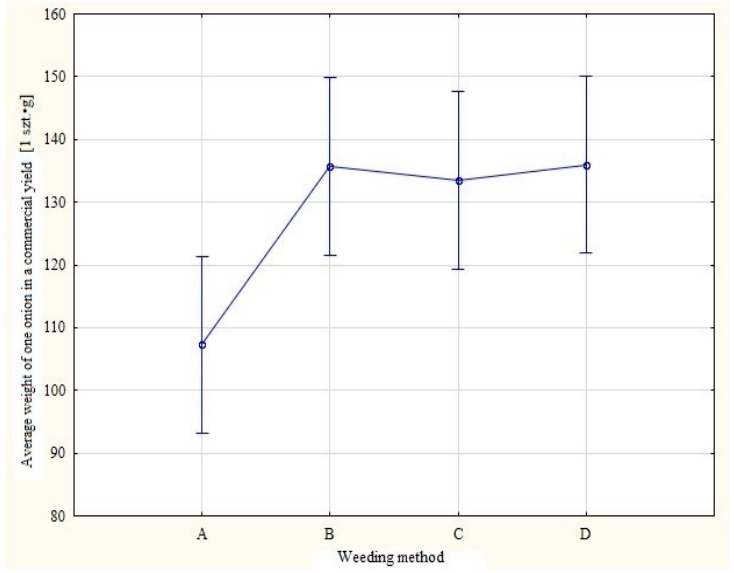
Figure 18. Expected marginal averages for 0.95 confidence intervals for the average weight of one onion in the commercial yield in 2018 (source: own work).